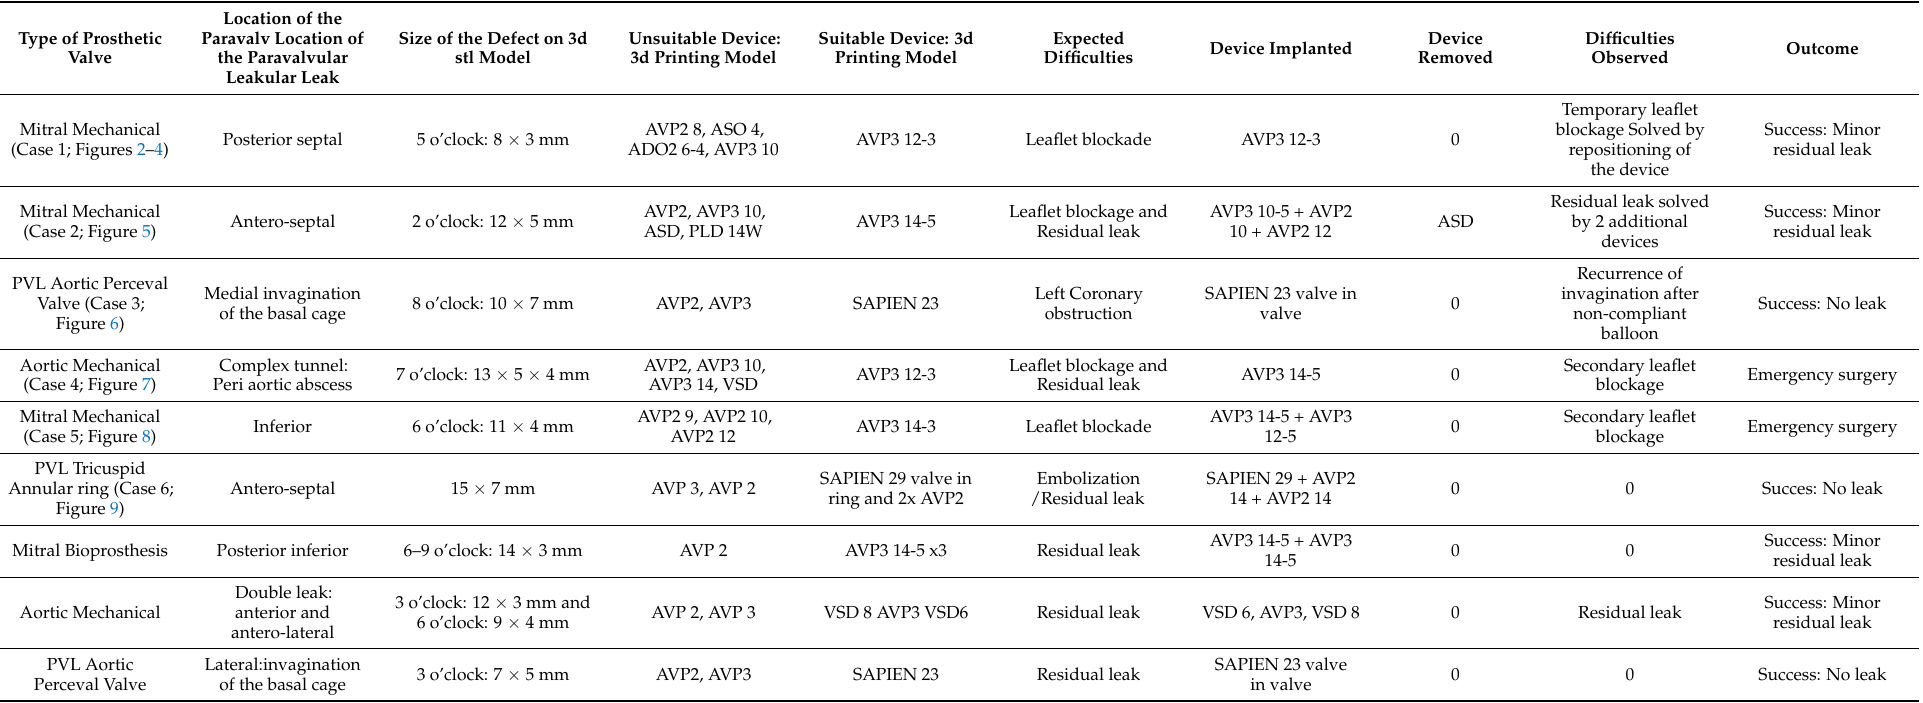
Table 1. Anatomical characteristics, operative strategies employed and outcome of cases with 3D printing